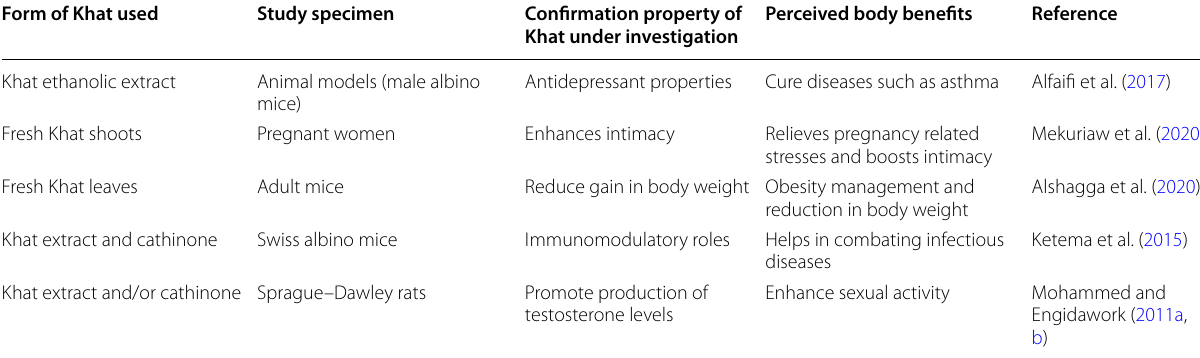
Table 2 Some biological uses of khat Form of Khat